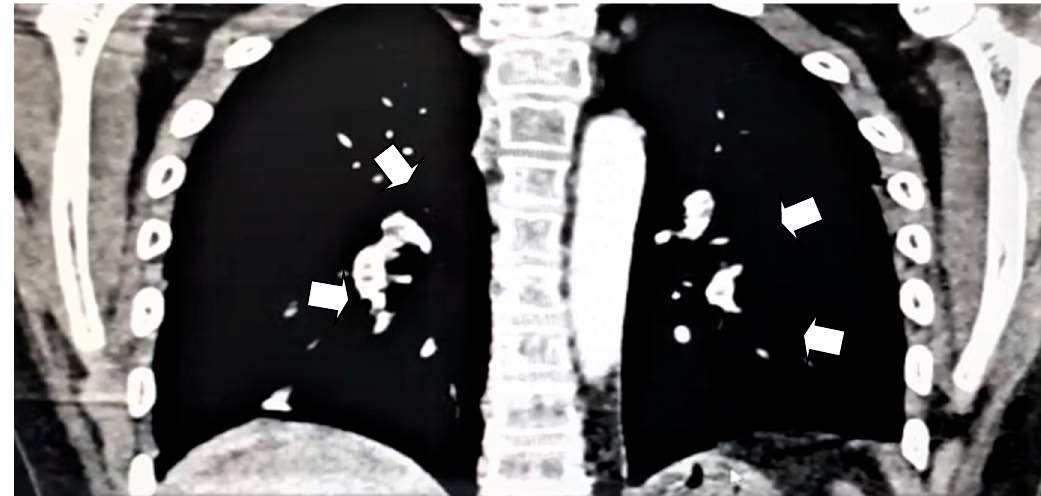
Figure 1. Computed tomography pulmonary angiogram showing filling defects of the right-middle, lower-lobar, and segmental pulmonary artery and of the left-upper, lower-lobar, and segmental pulmonary artery. White arrows indicate the defects.